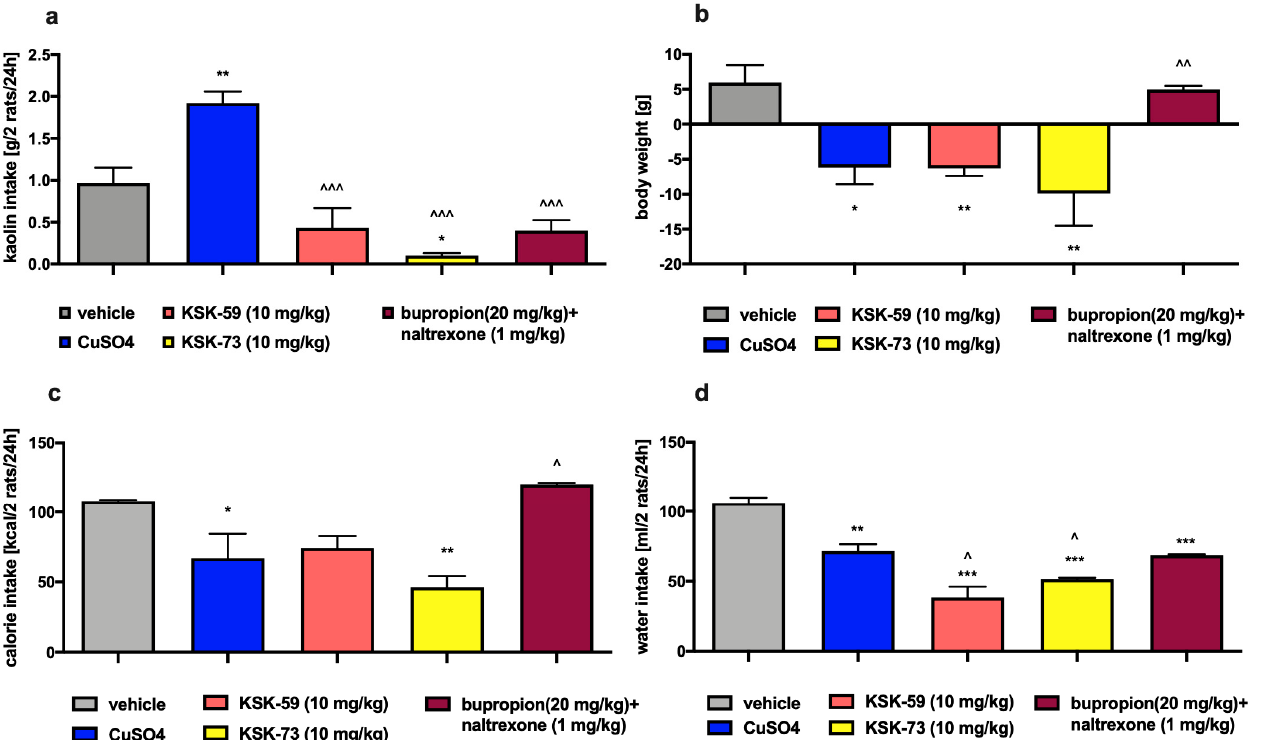
Figure 8. Effect of single administration of the tested compounds or bupropion/naltrexone on kaolin intake ( a ), body weight ( b ), calorie intake ( c ) and water intake ( d ) in female Wistar rats in the model pica behavior. Results are expressed as means ± SEM, n = 6. Comparisons were performed by one-way ANOVA, Tukey’s post hoc test. * Significant against control rats; ^ significant against control rats treated with CuSO 4 ; *, ^ p < 0.05, **, ^^ p < 0.01, ***, ^^^ p < 0.001.